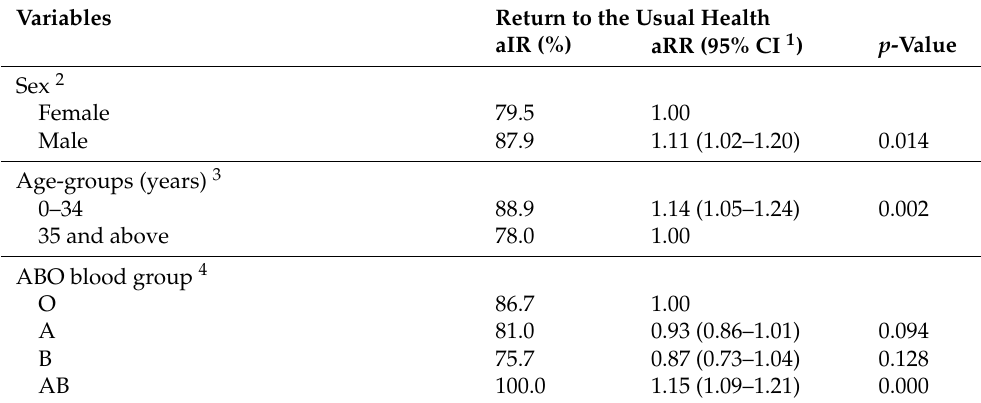
Table 8. Return to the usual health, risk factors, adjusted incidence ratio (aIR) and adjusted relative risk (aRR). Borriana COVID-19 cohort